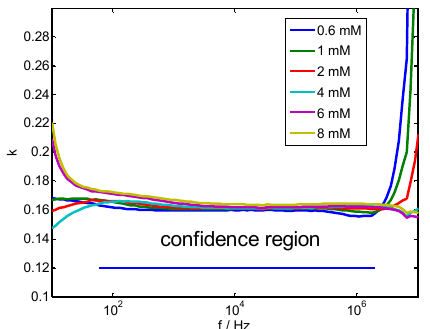
Fig.9: Geometry coefficient calculated over the frequency range for an electrode shown in Fig.6.